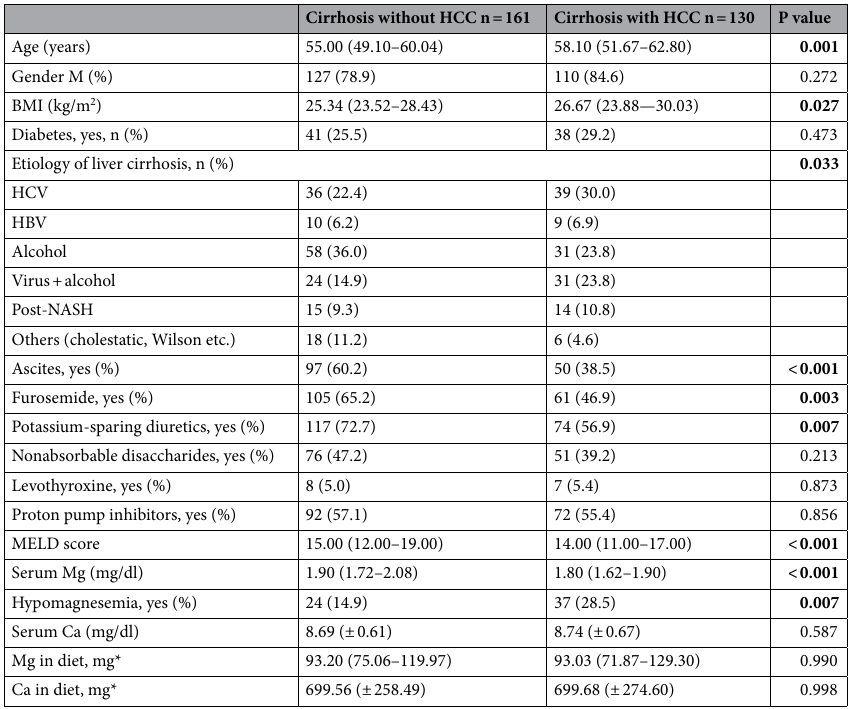
Table 1. Demographic and clinical characteristics according to the presence or absence of HCC in cirrhotic patients. Continuous variables are shown as median and interquartile range or mean ± SD, according to the absence or presence of normal distribution. Categorical variables are shown as numbers and percentages. The characteristics refer to the time of blood sampling to determine the concentration of Mg, corresponding to the first visit for patients without HCC and to the time of diagnosis of HCC for patients with cancer. BMI body mass index, Ca calcium, HBV hepatitis B virus, HCC hepatocellular carcinoma, HCV hepatitis C virus, MELD model for end-stage liver disease, Mg magnesium, NASH non-alcoholic steatohepatistis. *Available only in 52 cirrhotic without HCC and 39 cirrhotic with HCC. p-values numbers marked in bold indicate numbers that are significant at the p < 0.05